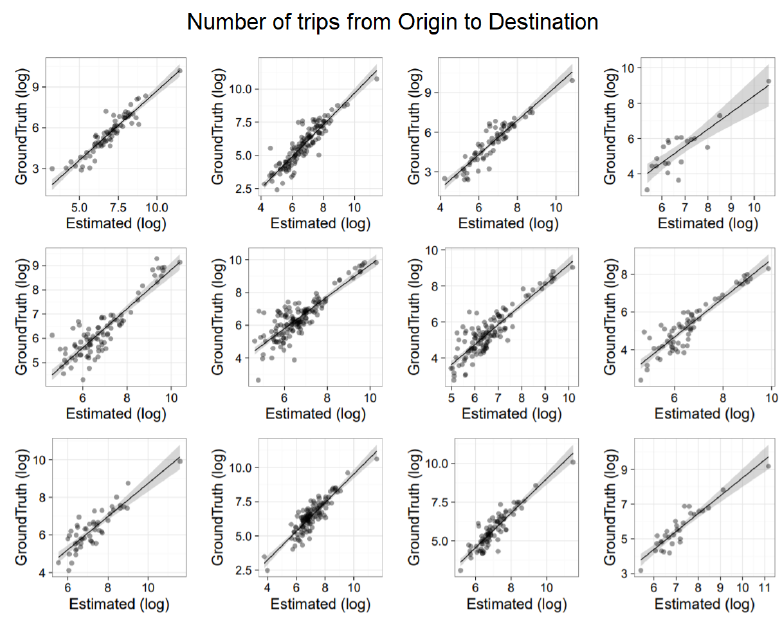
Figure 7. Comparison between the home–work commute with ISTAT data. ( top row ) provides results for Piemonte. ( middle row ), for Emilia Romagna. ( bottom row ), for Lombardia. In each row, we have four correlations associated to the four time intervals in which ISTAT data is organized, that is travel from home to work ( i ) before 7 a.m.; ( ii ) from 7 a.m. to 8 a.m.; ( iii ) from 8 a.m. to 9 a.m.; ( iv ) after 9